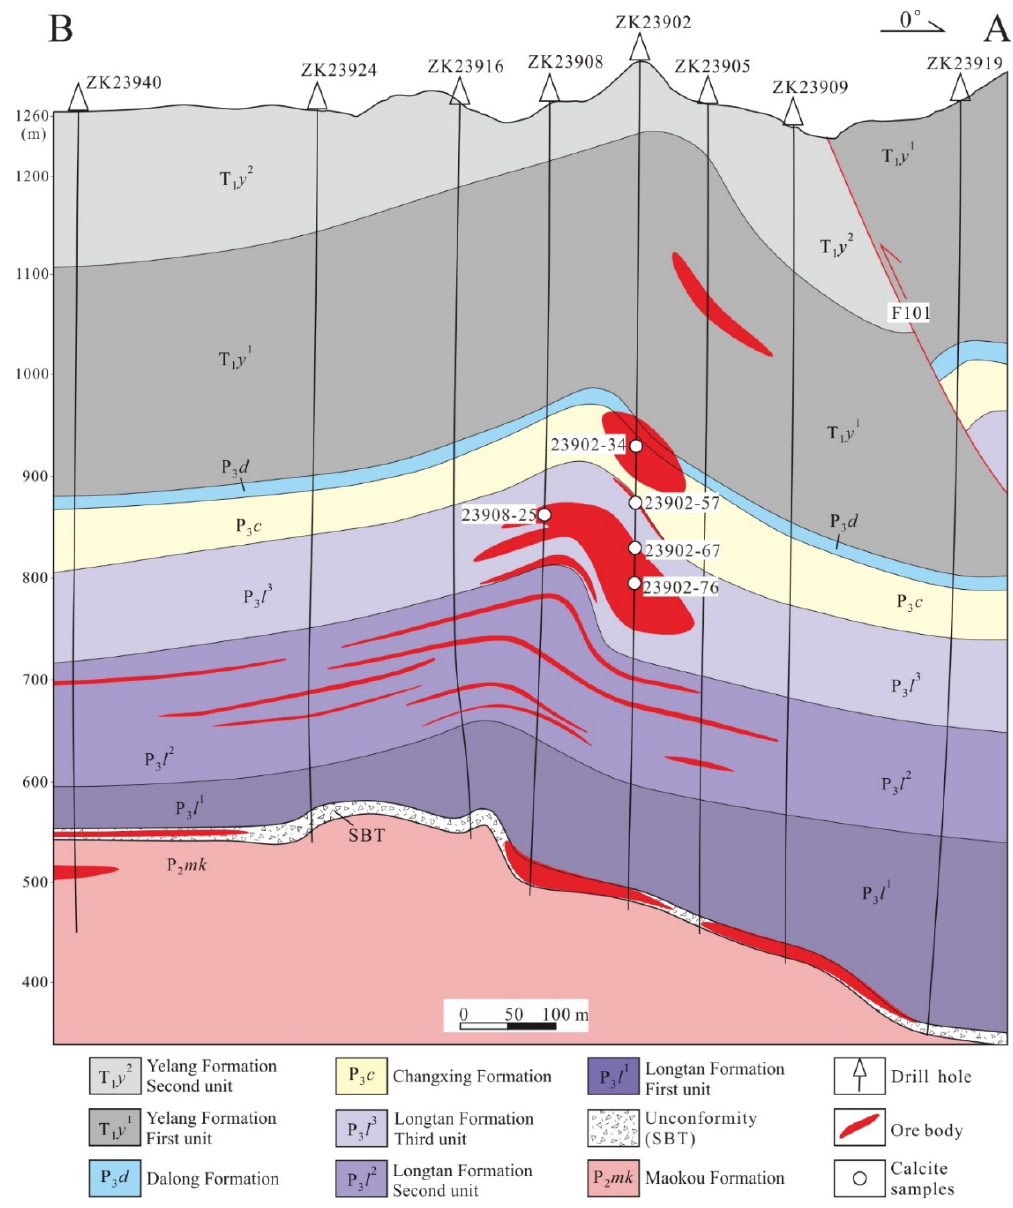
Figure 3. Geological cross section A–B through the Shuiyindong mining area (looking west) showing its major structures and stratigraphic units.